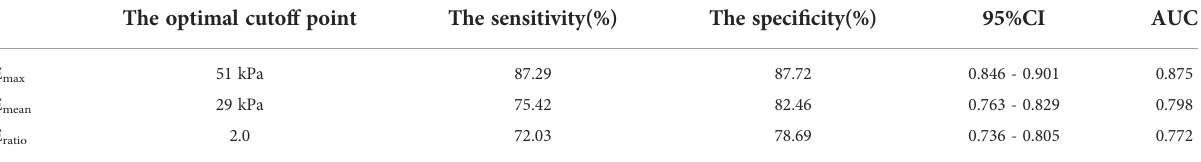
TABLE 4 Statistical analysis of using SWE parameters to differentiate benign and malignant thyroid lesions.